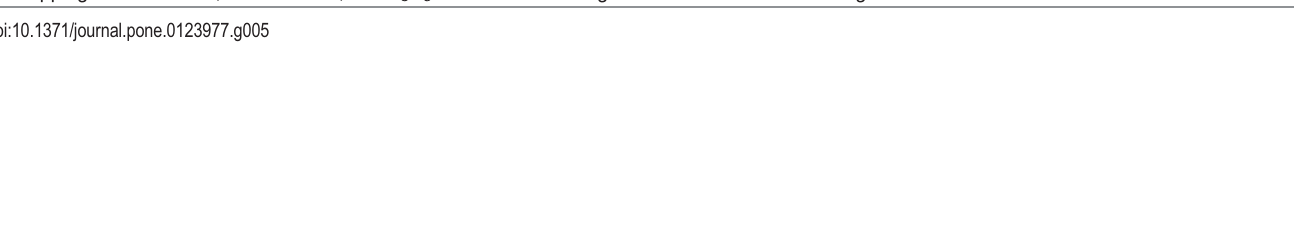
PLOS ONE | DOI:10.1371/journal.pone.0123977 April 20,